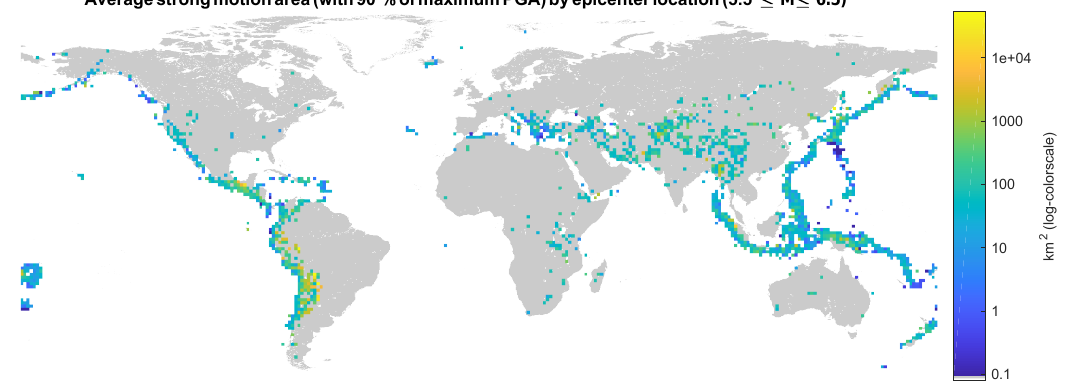
Average strong motion area (with 90 % of maximum PGA) by epicenter location (5.5